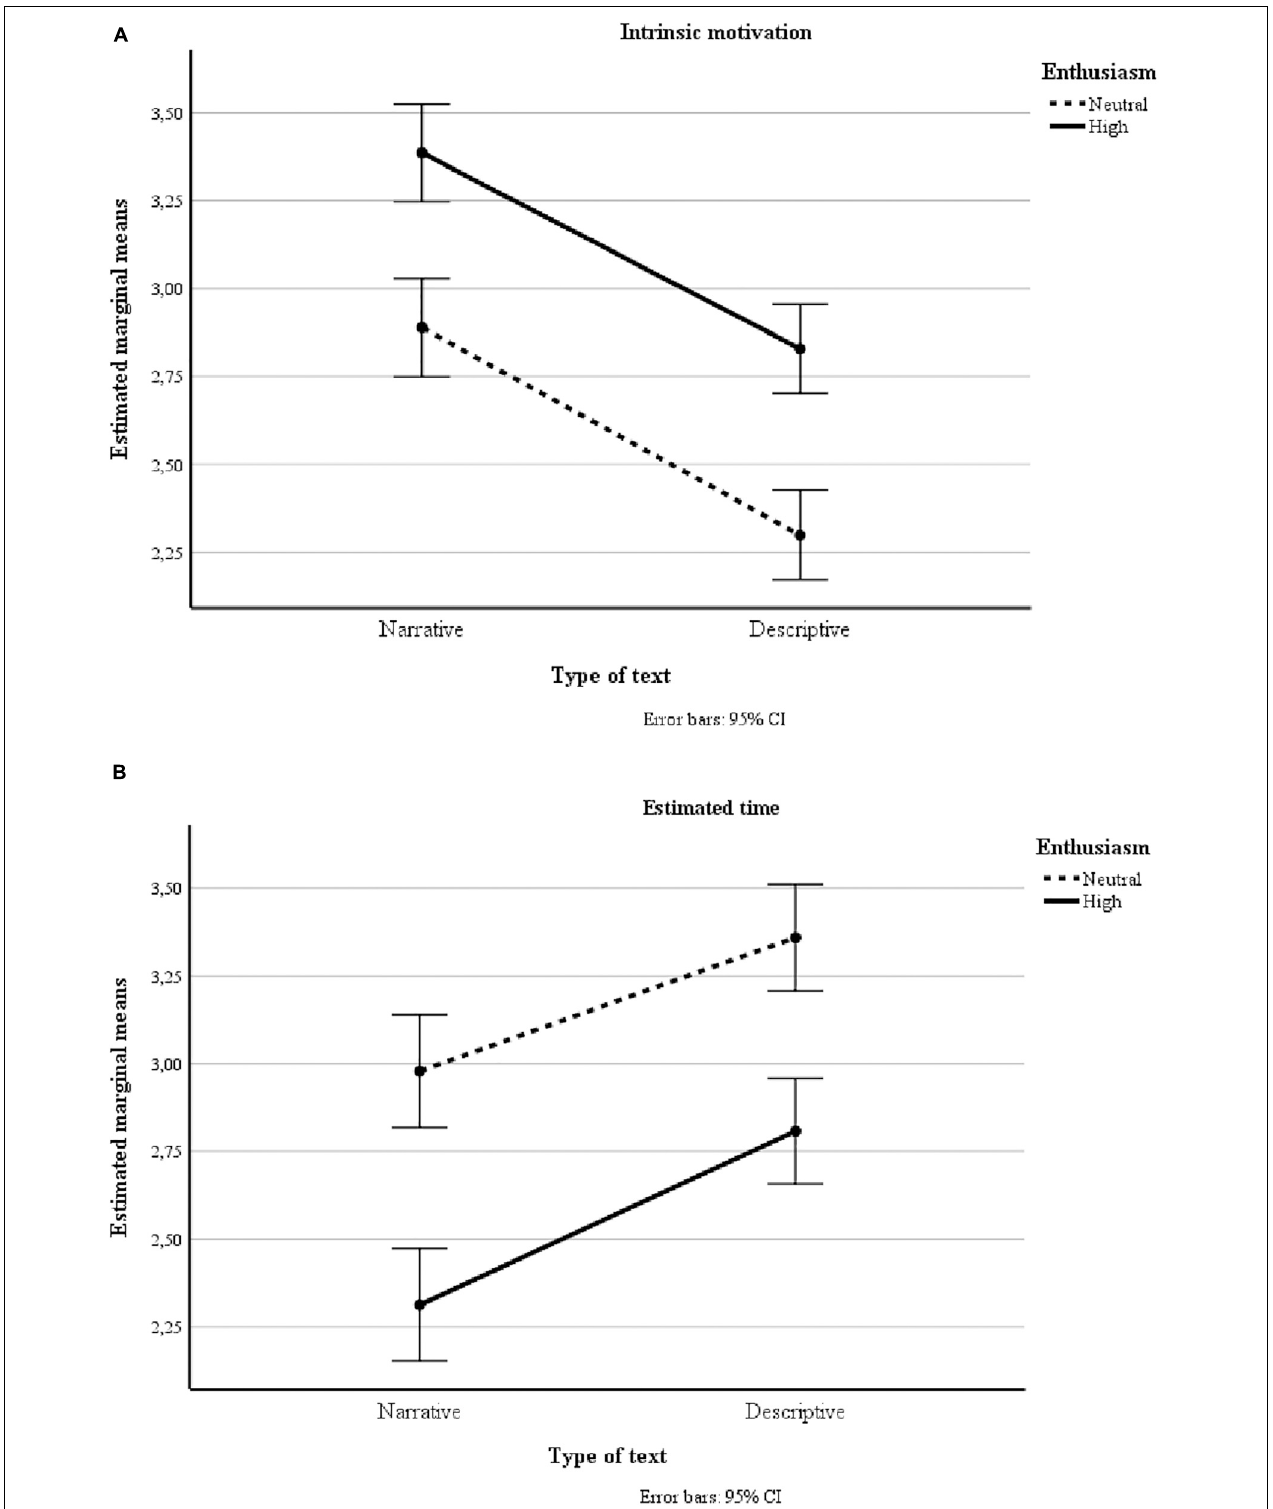
FIGURE 1 | Estimated marginal means for intrinsic motivation (A) and estimated time (B) by teacher enthusiasm and type of text.